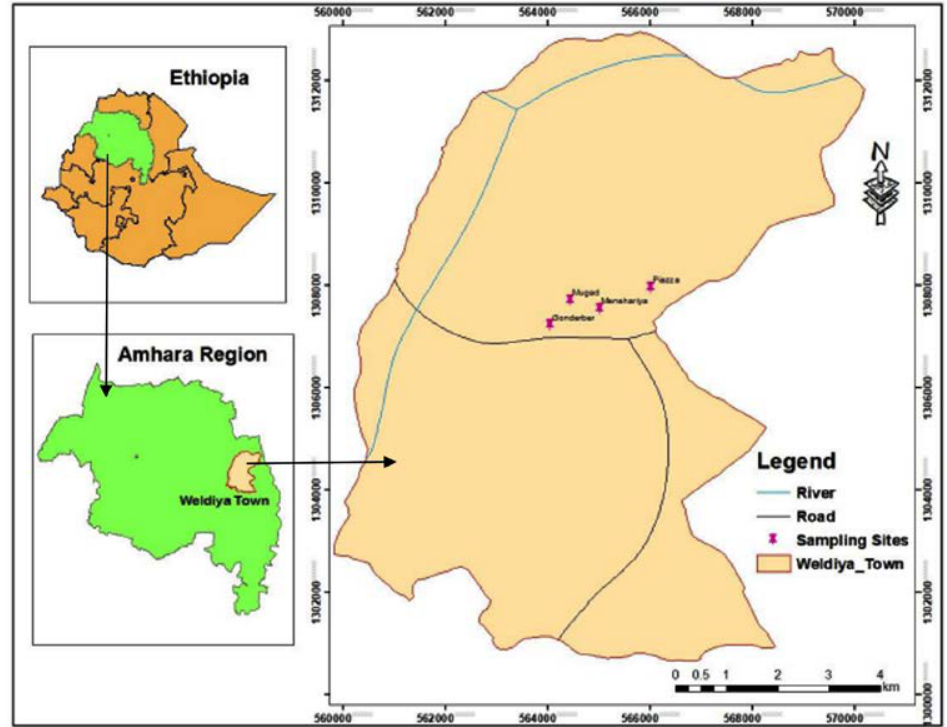
Fig. 1. Street food sampling sites in Woldia